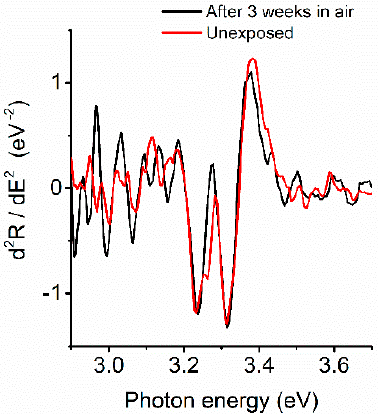
Figure 11. Comparison of reflectance curves (2nd derivative) for aluminium oxide-capped sample Q8 before and after approximately 3-week exposure to ambient air.